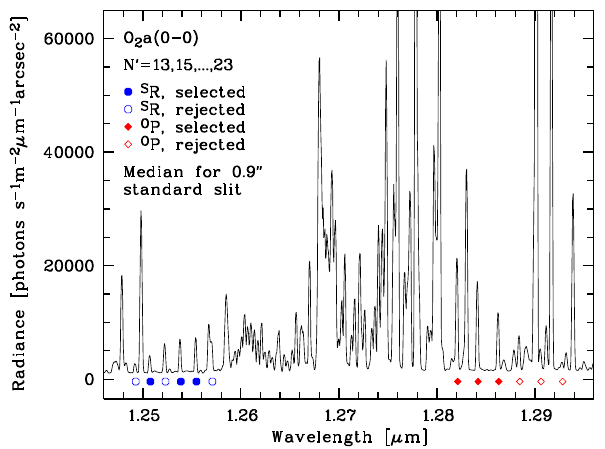
Figure 4. Derivation of O 2 b (0-1) T rot under the assumption of a Boltzmann distribution for the different rotational levels. The ab- scissa shows the HITRAN-based energy of a given level in cm − 1 . The ordinate displays the natural logarithm of the HITRAN-based population of a hyperfine-structure level relative to 1 Rayleigh sec- ond. Resulting from P Q and P P line intensities, the mean popu- lations of the even rotational levels with N (cid:48) from 0 to 18 for the full X-shooter sample are shown. Filled symbols mark reliable data points that were used for the derivation of T rot (see Fig. 3), which is illustrated by the solid regression line.